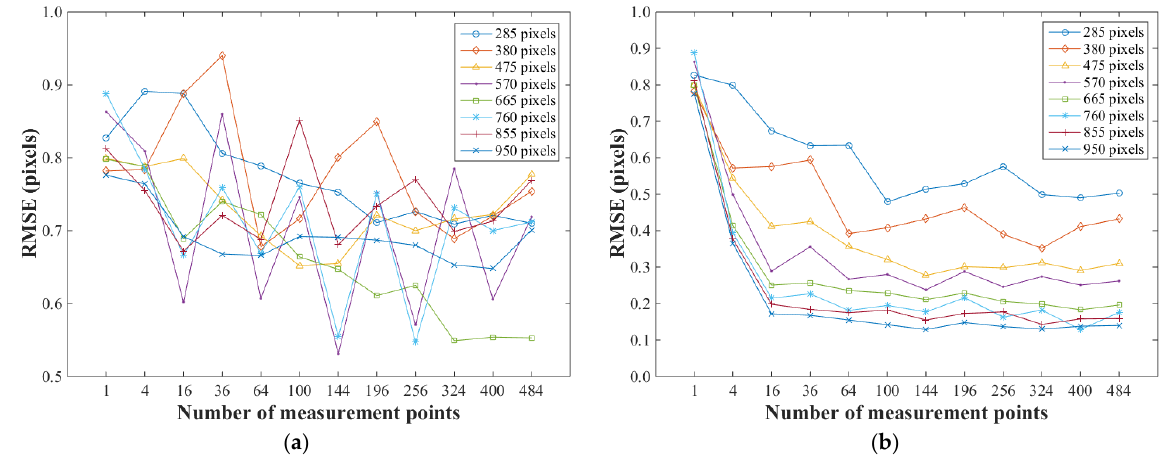
Figure 5. RMSE of the displacement measurement results before and after the optical-turbulence error mitigation for different targets ( a ) before mitigation and ( b ) after mitigation.